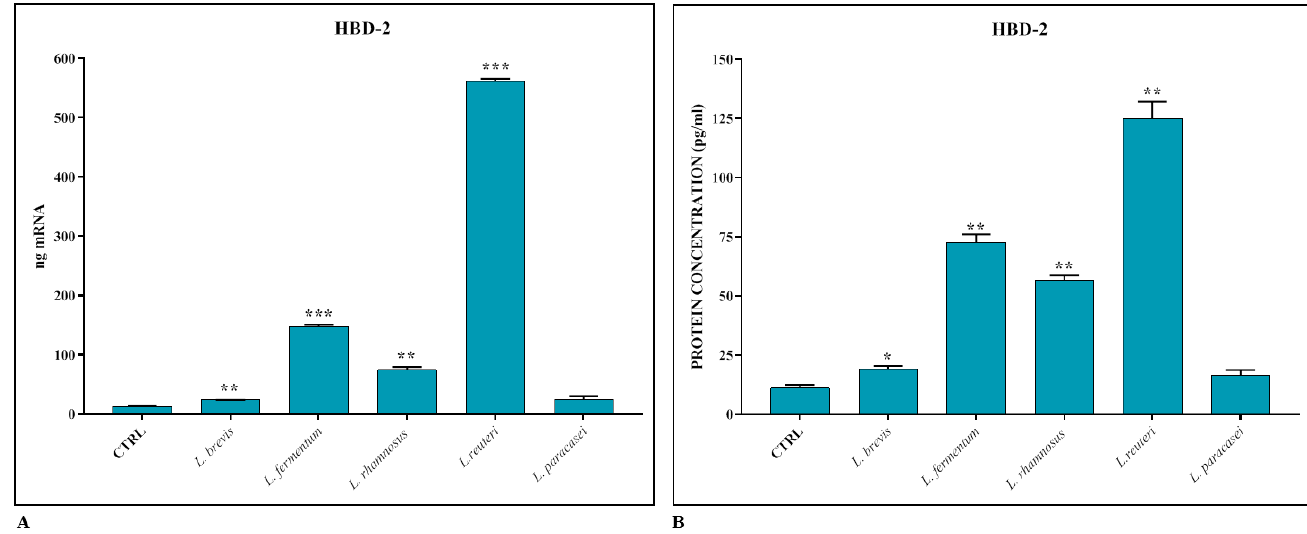
Figure 2. Gene expression ( A ) and protein concentration ( B ) of HBD-2 in Caco-2-HT29-MTX co- cultures treated with different strains of Lactobacillus spp. The data are representative of three different experiments ± SD. Significant differences are indicated by * p < 0.05, ** p < 0.01, *** p < 0.001.